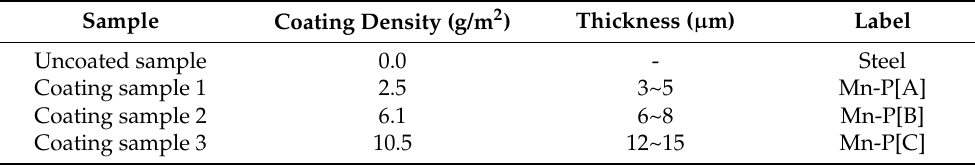
Table 1. Sample density of manganese phosphate conversion coating.